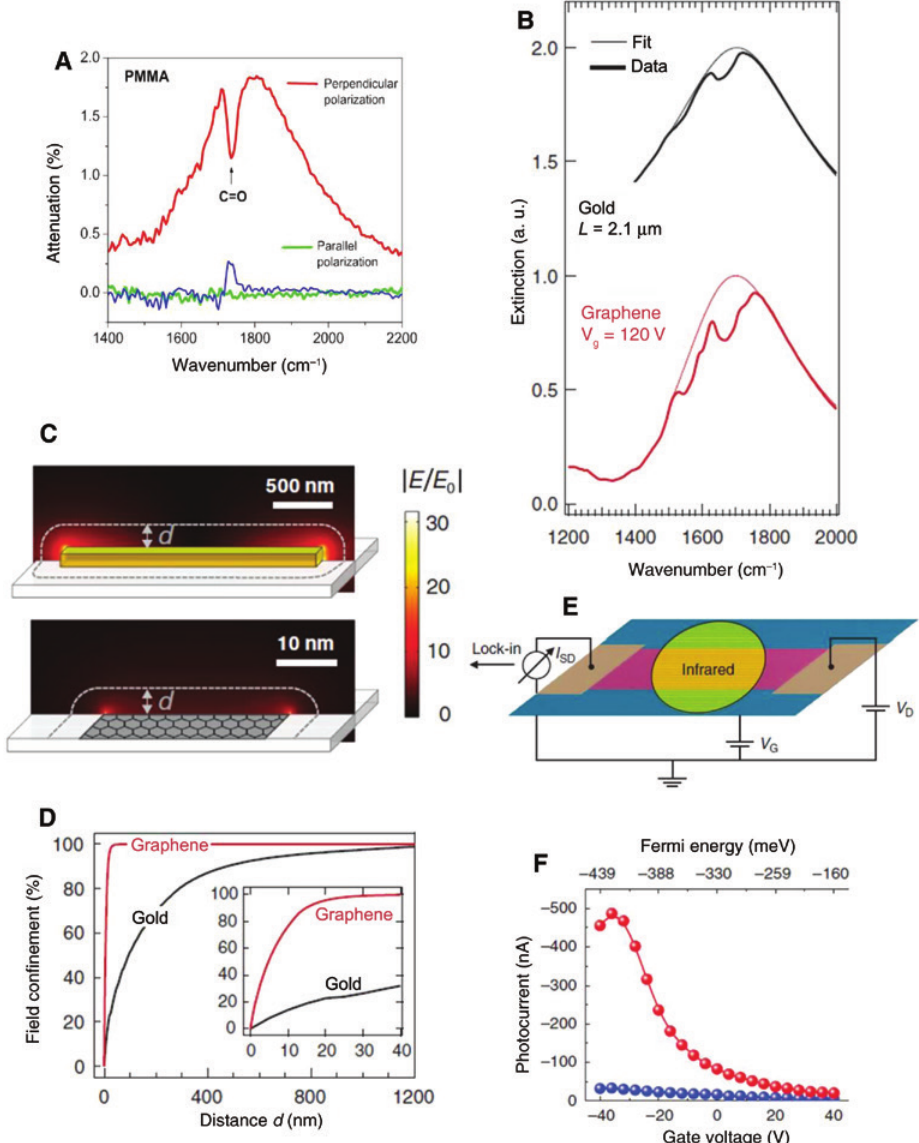
Figure 8: Graphene plasmon applications in sensing and photodetection. (A) Infrared absorption spectrum of graphene nanoribbons covered with a thin layer of PMMA. (B) Extinction spectra of graphene and gold biosensors covered with a protein layer. The thick curves are the measured spectra and the thin curves are the fittings for bare graphene and gold biosensors. (C) Calculated near-field distribution for gold (top panel) and graphene (bottom panel) biosensors at frequency 1600 cm −1 . (D) Field confinement percentage as a function of the distance from the biosensor surface for both graphene and gold. The inset is the enlarged version in the small distance d regime. (E) Graphene nanoribbon photodetector with electrical gate. (F) Gate and polarization dependence of the photoresponse for the ribbon array shown in E. The red dots are for the perpendicular polarization, whereas the blue dots are for the parallel case. (A) Reproduced by permission from [24]. © Copyright 2014 American Chemical Society. (B–D) Reproduced by permission from [25]. © Copyright 2015 AAAS. (E and F) Reprinted by permission from [69]. © Copyright 2013 Nature Publishing